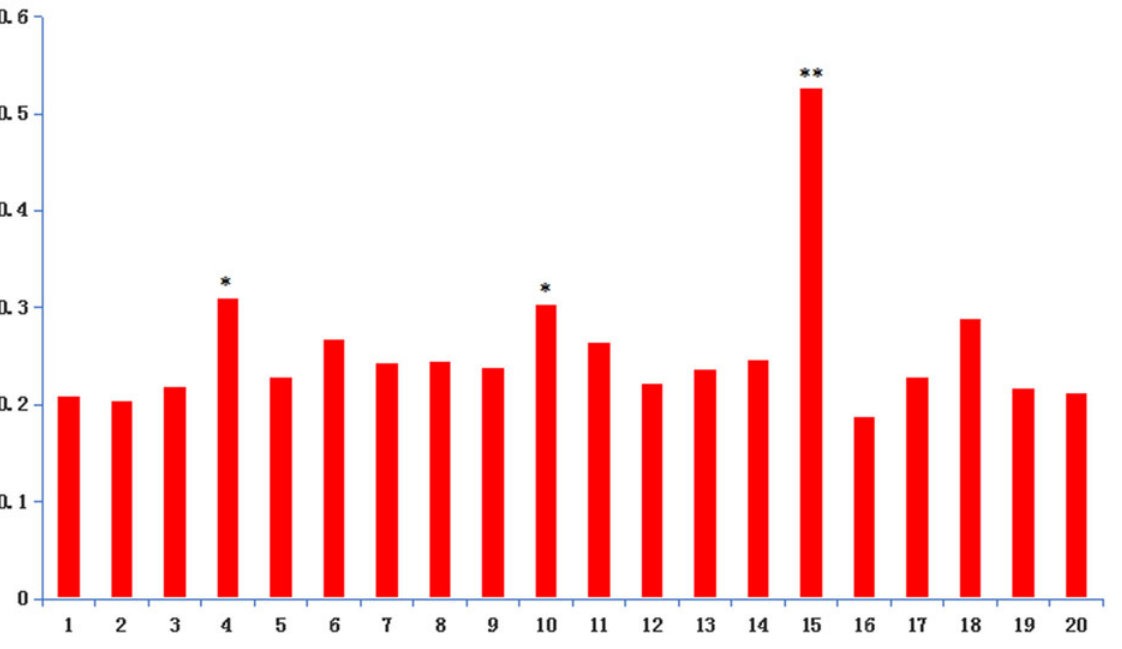
Figure 6: Gray correlation analysis method of the compounds identified in Cistanche . SPSS version 21.0 was used to analyze the data. The red column is the uterine indices. The correlation coefficients higher than 0.3 were considered significant (*p < 0.05), whereas correlation coefficients higher than 0.5 were considered highly significantly (**p < 0.01). A total of three compounds exhibited the highest correlation with the uterine indices, namely 8-epiloganic acid, cistanoside F, and